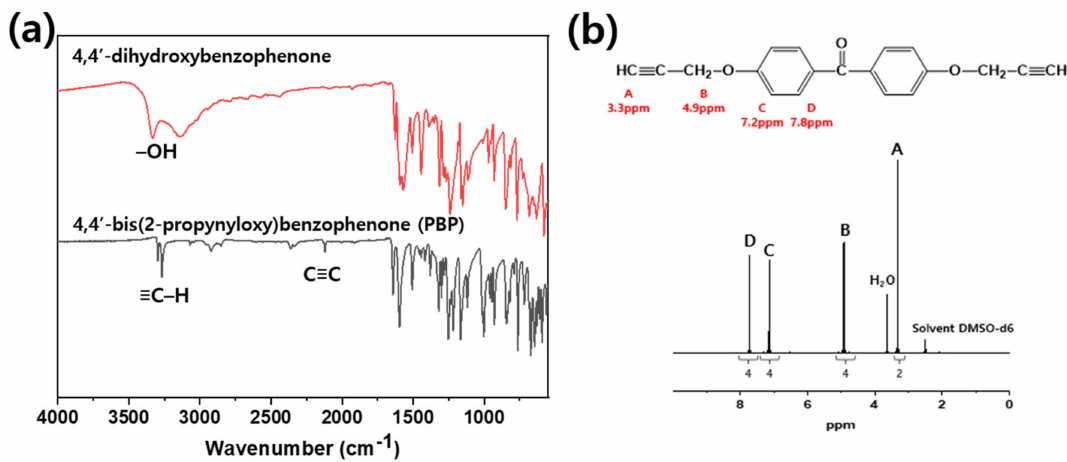
Figure 4. ( a ) FT-IR and ( b ) 1 H-NMR spectrum of